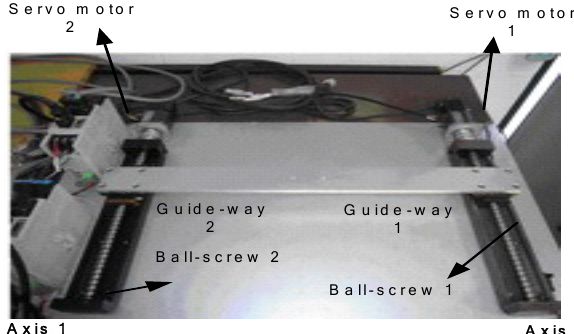
Figure 2. The hardware structure of the gantry robot.